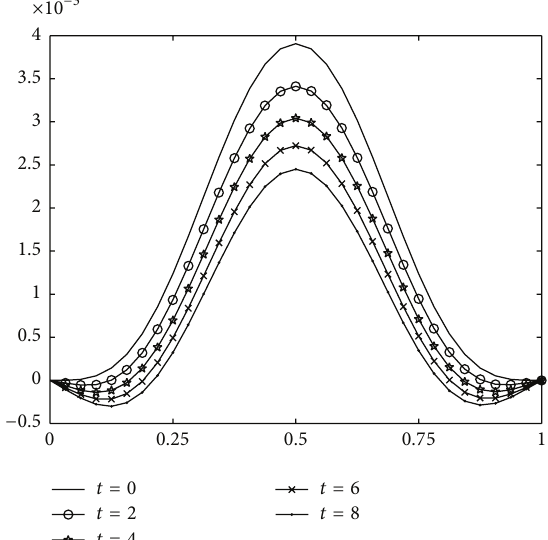
Figure 5: Numerical solutions at different time with ℎ = 1/32 , 𝜏 = 0.1 , 𝛽 = 1 , 𝛼 = 2 , and 𝑝 = 4 .